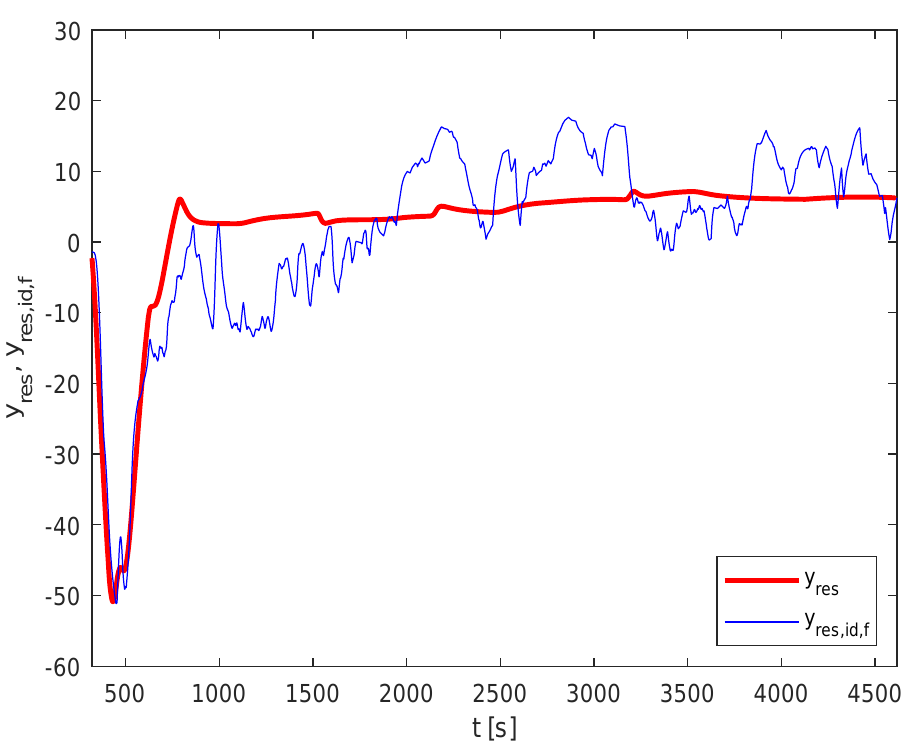
Figure 6. Residual dynamic model validation: y res and y res , id , f . Finally, the output of the improved model is calculated according to Equation (7). The relevant BIS trajectories are shown in Figure 7.